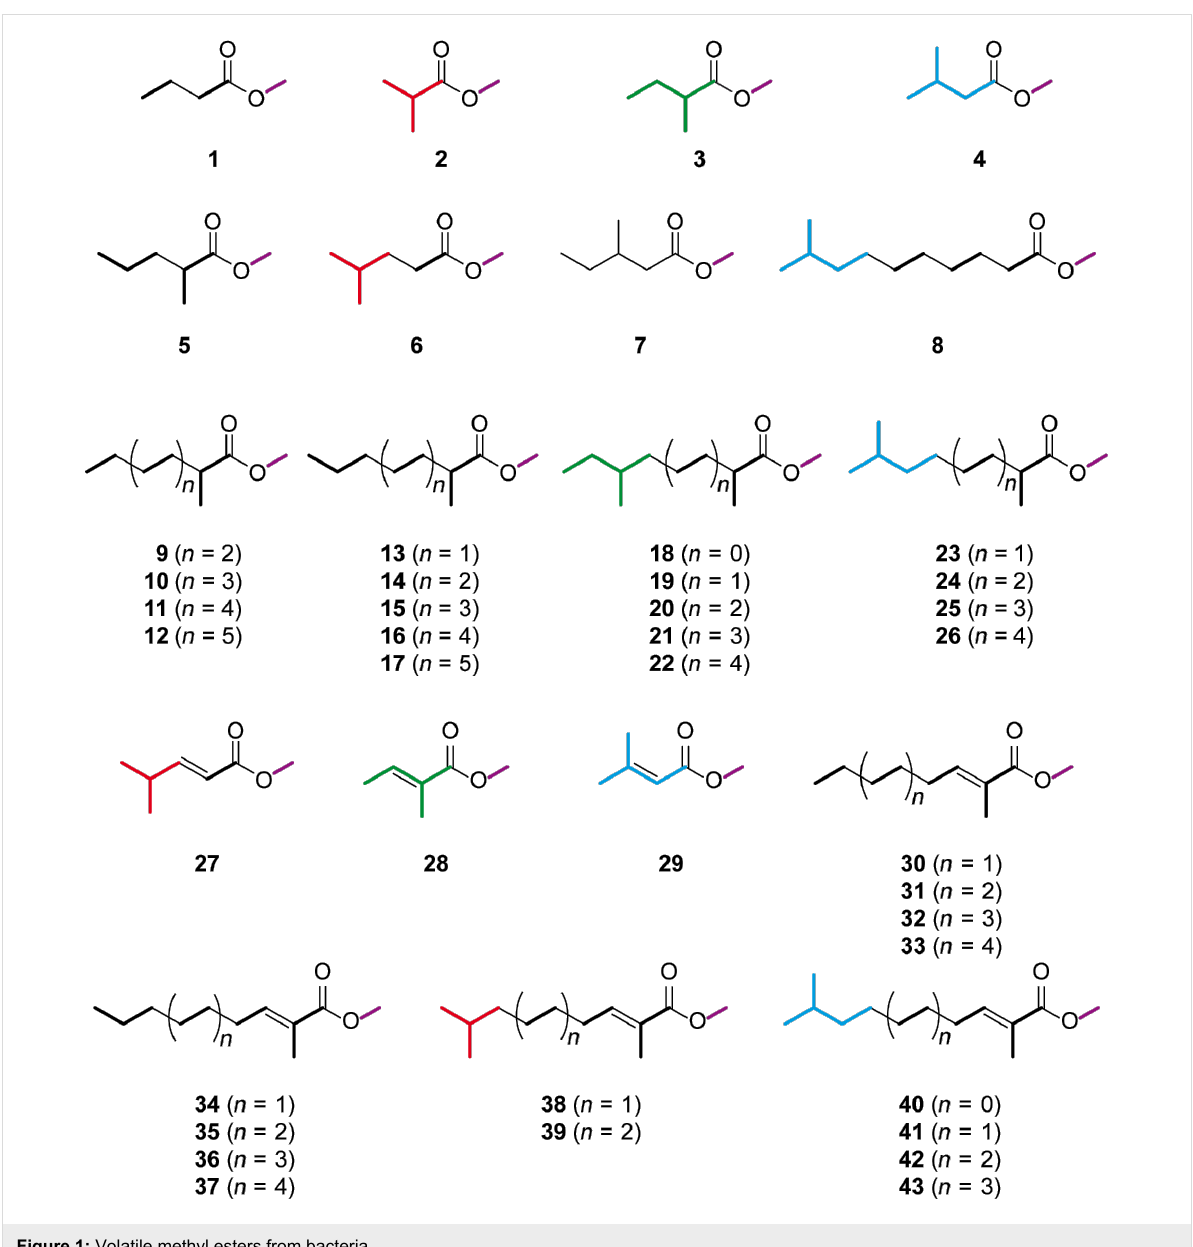
Figure 1: Volatile methyl esters from bacteria.